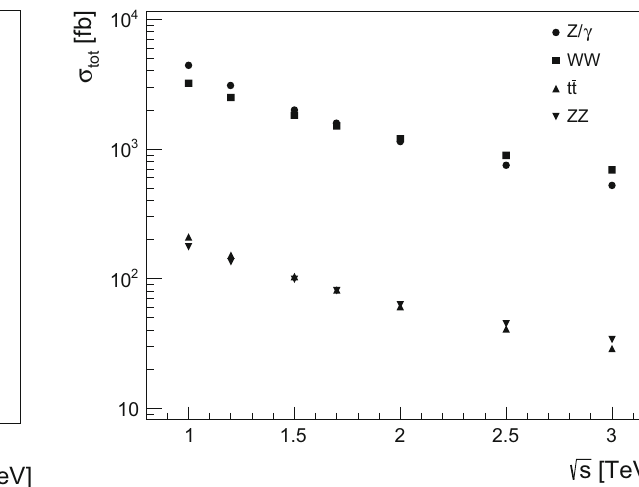
( a ) The signal total cross section as a function of center of (b) The Background total cross section as a function of Fig. 7 Signal and background cross sections down to the CLIC